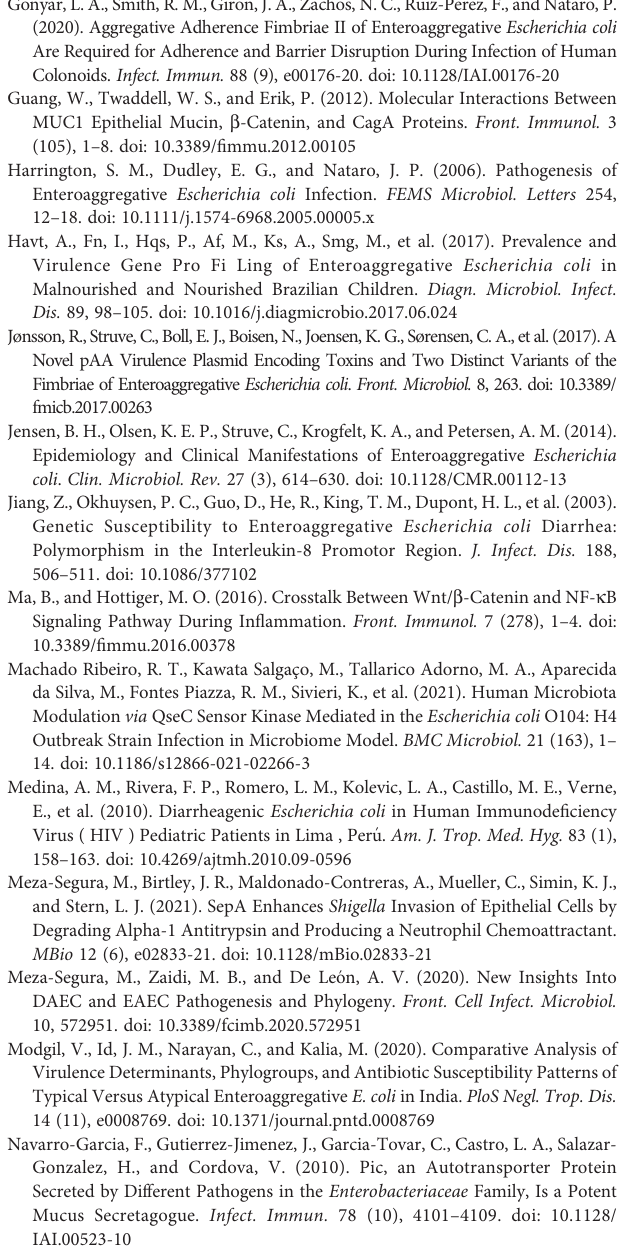
Supplementary Figure 1 | Prediction offunctional microbial metabolic pathways using PICRUSt analysis. The abundance of statistically signi fi cant metabolic pathways (A) KEGG level 2 and (B) KEGG level 3 between mice EAEC-infected (red colour) and uninfected (green colour) bacterial communities. All statistically signi fi cant pathways (p <